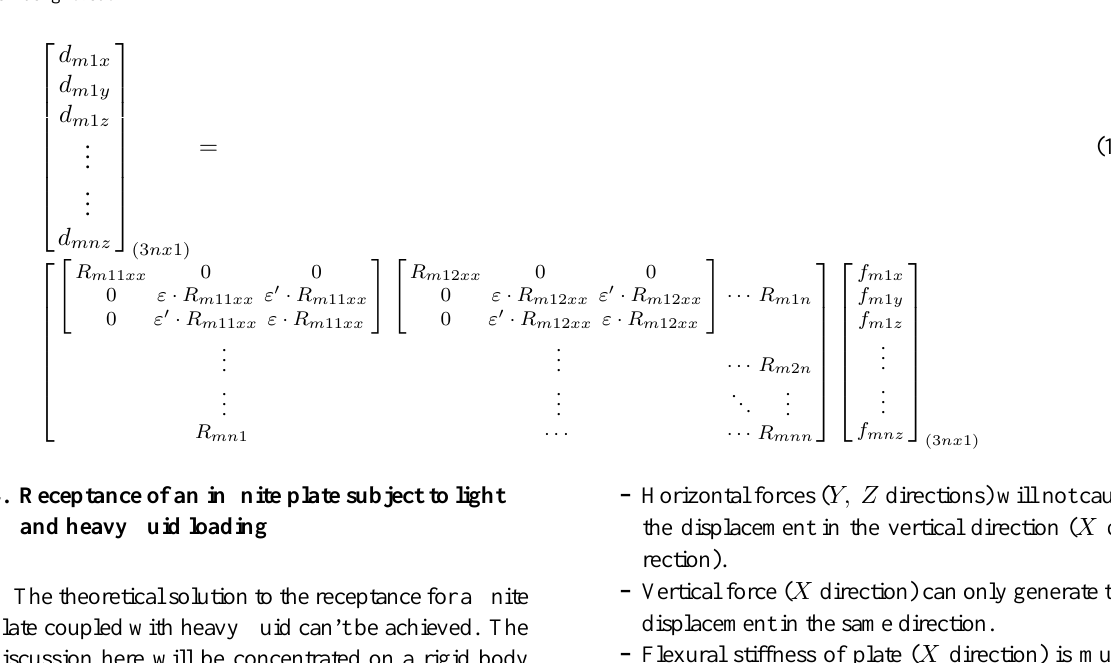
Fig. 2. The integration contour used to evalute the transfer receptance. Since the analysis is below the critical frequency, the leaky wave poles can be